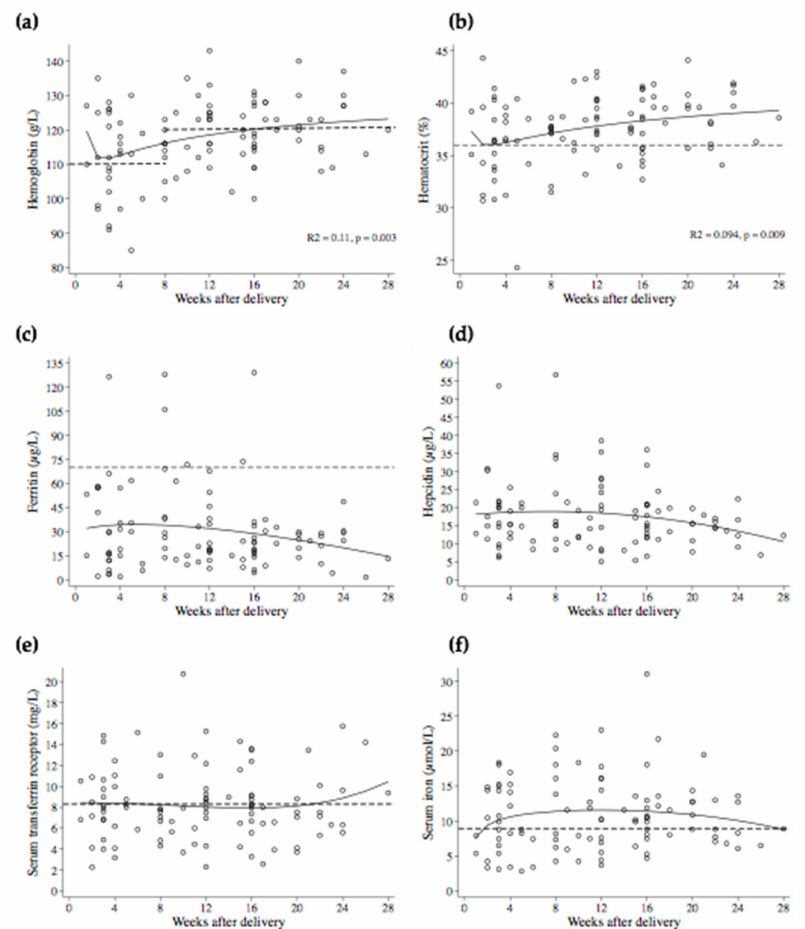
Figure 1. Scatter plots of iron status indicators by weeks after delivery. Solid lines show fractional polynomial regression lines. Spearman correlations showed significant correlations of ( a ) hemoglobin (r s = 0.28, p = 0.005) and ( b ) hematocrit (r s = 0.28, p = 0.005) with weeks post-partum, and non- significant correlations of ( c ) ferritin (r s = − 0.09, p = 0.36), ( d ) hepcidin (r s = − 0.12, p = 0.24), ( e ) serum transferrin receptor (r s = − 0.007, p = 0.94), and ( f ) serum iron (r s = 0.07, p = 0.51) with weeks post- partum. Dashed lines indicate cut-offs for deficiencies according to WHO, except for hepcidin, for which no official cut-off is